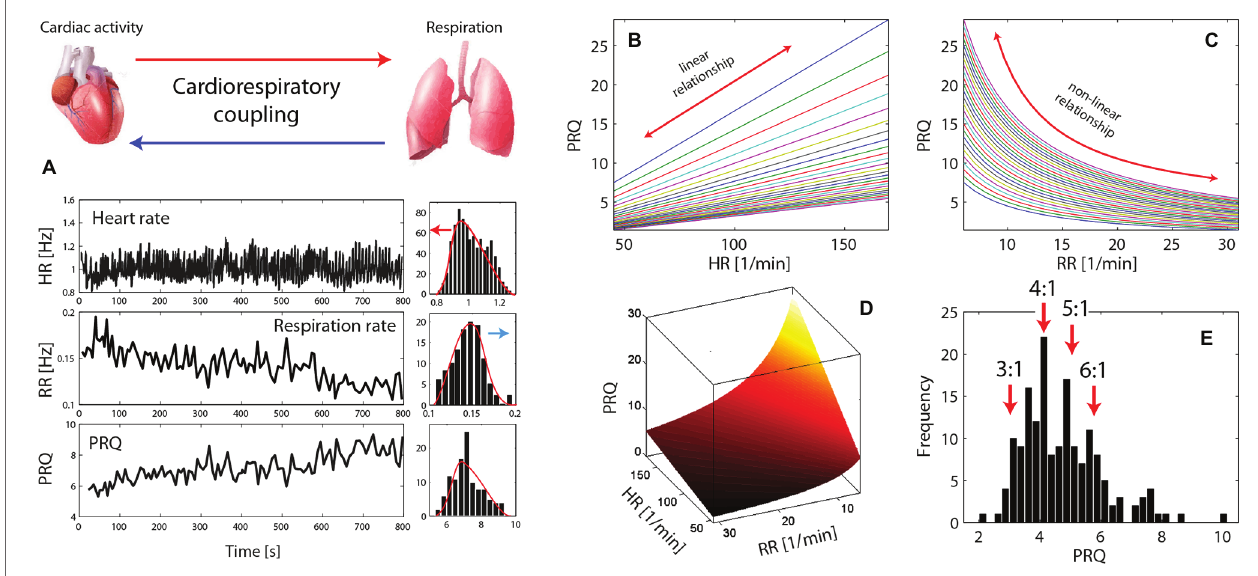
FIGURE 1 | (A) Illustration of the principle of cardiorespiratory coupling (CRC) and exemplary time series of heart rate (HR), respiration rate (RR), and the pulse- respiration quotient (PRQ) (data extracted from Lotri č and Stefanovska, 2000). On the right side of each time series, the histograms are shown exhibiting clearly the phenomenon of the complex interplay between the intrinsic oscillations and coupling of the oscillators causing a deviation of the intrinsic frequencies as evident by the skewed distributions of HR and RR. The directions of deviations are marked with arrows. (B–D) The relationship of the PRQ with HR and RR [simulation; normal ranges of human HR and RR values are used (from resting state to intense physical activity), i.e., HR = 45–170 1/min, RR = 6–31 1/min]. (D) PRQ-HR-RR space where the extreme PRQ values (PRQ > 10 and < 2) are mainly due to pathophysiological states. (E) The quantization phenomenon of the PRQ ( n : m ratio with n = 3–6 and m = 1 is shown as often observed in human PRQ studies) (data extracted from Moser et al.,